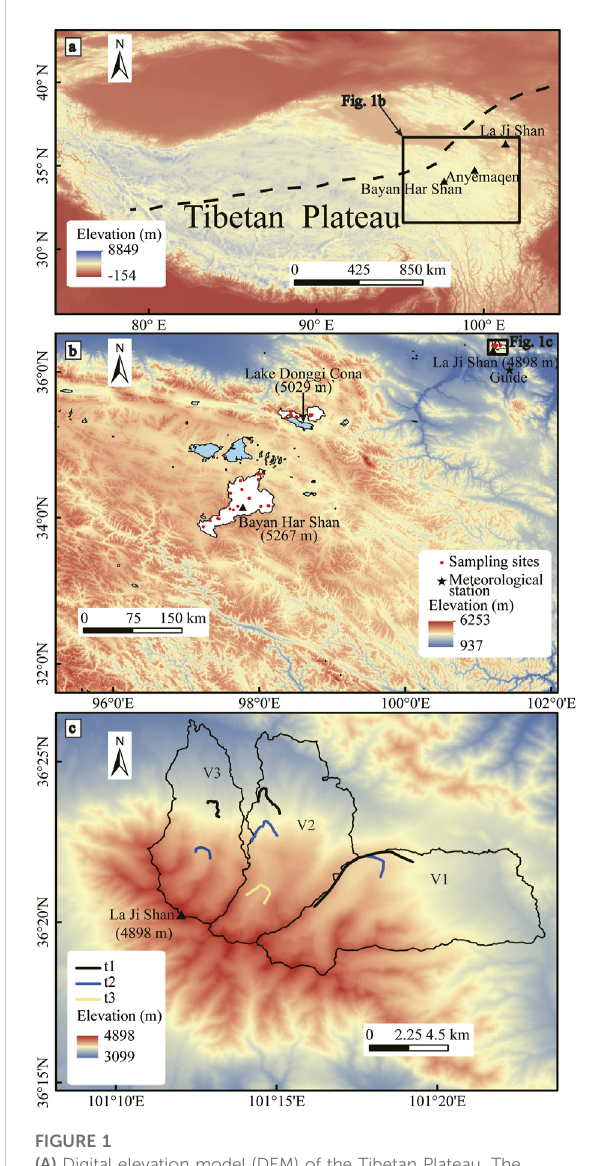
FIGURE 1 (A) Digital elevation model (DEM) of the Tibetan Plateau. The dashed black line represents the limit of the modern Asian summer monsoon(modi fi edafterChenetal.,2008). (B) Thespatialdistribution of meteorological stations close to the La Ji Shan, Bayan Har Shan, and Lake Donggi Cona areas. White areas are where samples were collected in the La Ji Shan, Bayan Har Shan, and Lake Donggi Cona areas for 10 Be exposure dating. (C) Locations of the three moraine groups in the La Ji Shan (modi fi ed after Owen et al., 2003b).